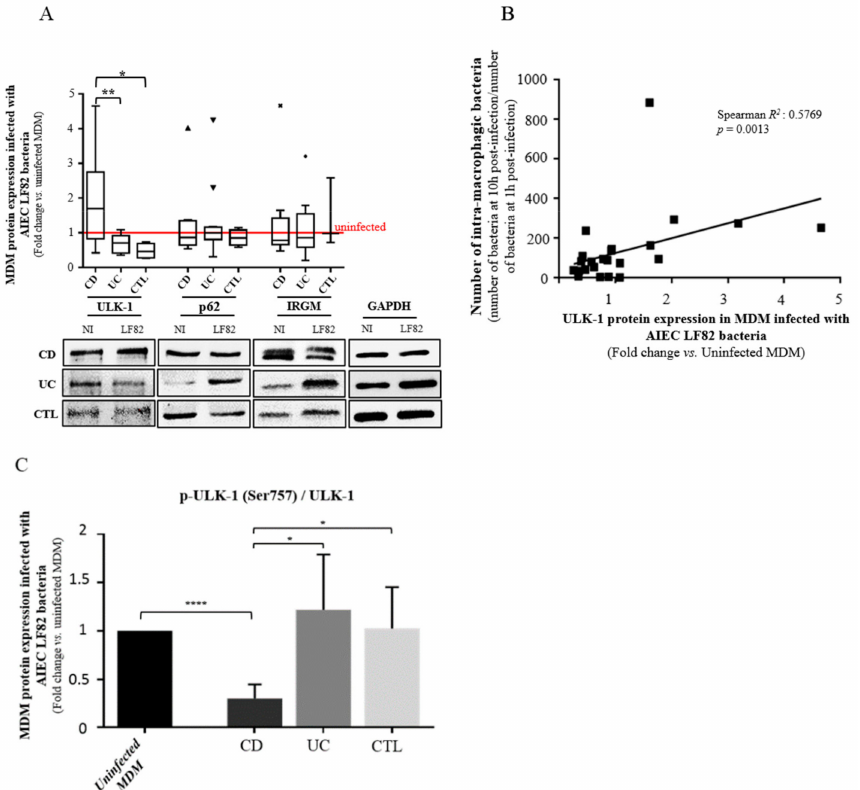
Figure 4. Influence of autophagy-related ULK-1 protein expression and activity on bacterial clearance within MDM from CD patients. ( A ) Western blot and quantification of ULK-1, p62 and IRGM proteins levels in MDM from CD patients ( n = 10), UC patients ( n = 12) and healthy volunteers ( n = 4 for ULK-1 and P62 protein levels and n = 3 for IRGM protein level), infected during 10 h or not with AIEC LF82 bacteria. Results are quantified relative to GAPDH. ( B ) Correlation between the number of intra-macrophagic bacteria reflecting the bacteria survival and ULK-1 protein level in MDM infected with AIEC LF82 ( n = 26). ( C ) Western Blot quantification of p-ULK-1 Ser757 protein level in MDM from CD patients ( n = 13), UC patients ( n = 14) and healthy volunteers (CTL) ( n = 14), infected during 10 h or not with AIEC LF82 bacteria. All the subjects included in this analysis are from the clinical protocol. Results are quantified relative to total ULK-1. (mean ± s.e.m., * p < 0.05, ** p < 0.01, **** p <